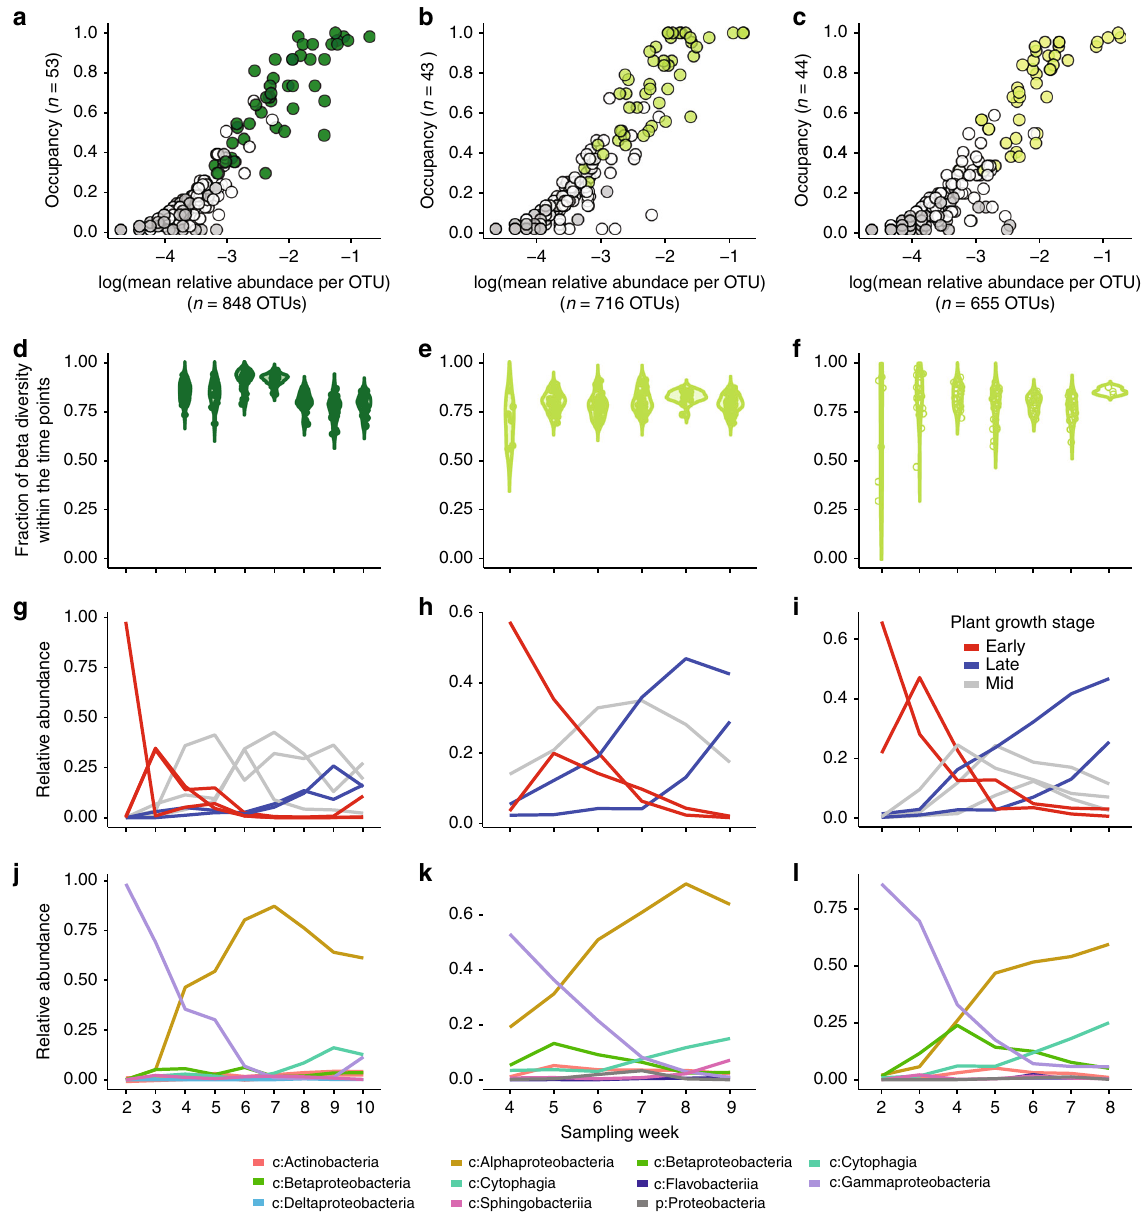
Fig. 4 Selection and dynamics of core phyllosphere members. Abundance-occupancy of leaf taxa for a miscanthus 2016, b switchgrass 2016, and c switchgrass 2017, and their inclusion in their respective cores. Each point is an OTU. Abundance-occupancy distributions were calculated at each time point, and taxa that had 100% occupancy at any time point (e.g., were detected in all replicate plots at one sampling date) were included in the core (green fi lled circles). Non-core taxa that were detected in both crops (white/open circles), and crop-speci fi c taxa (gray) are also indicated. d – f Contributions of the core taxa to changes in beta diversity over time. g – i Patterns of core taxa that share similar temporal changes, as determined by hierarchical clustering of standardized dynamics. Red lines are taxa that have early peaks in relative abundance, blue lines are late, and gray lines are mid-season. Colors correspond to the dendrograms in Fig. S7. j – l Patterns of core taxa summed by relative abundances within bacterial class. c: is class and p: is phylum, and lines are colored by taxonomic